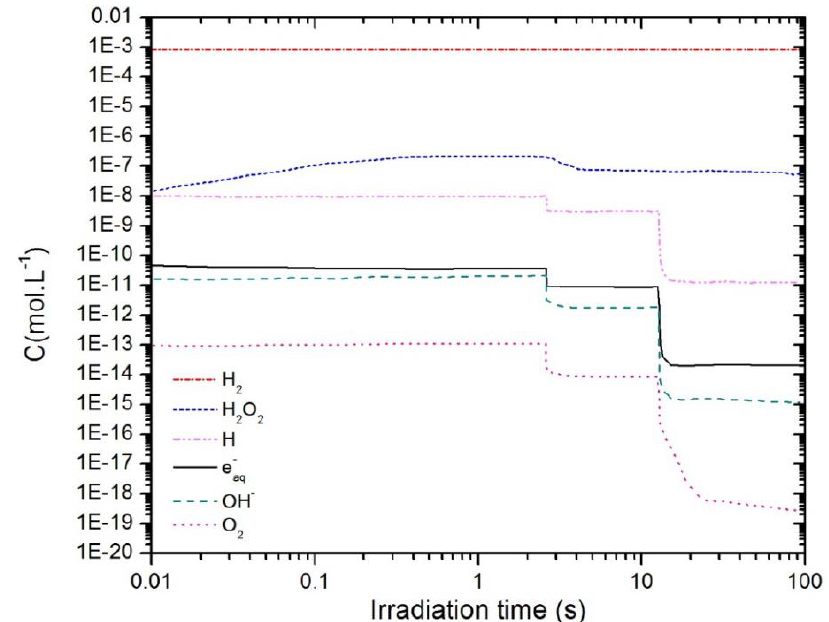
Figure 18. Predicted concentrations of radiolysis products with the passage of the coolant through the three radiation zones for Case 1. [H 2 ] = 2 ppm, T(irradiation zone) = 150 °C, T(nonradiated zone) = 100 °C, absorbed energy: Field 1; 0.021 W/g (n); Field 2; 0.0015 W/g (γ) (after Sato et al. [25]). © 2006 ITER Organization. This image is hereby used courtesy of the ITER Organization.